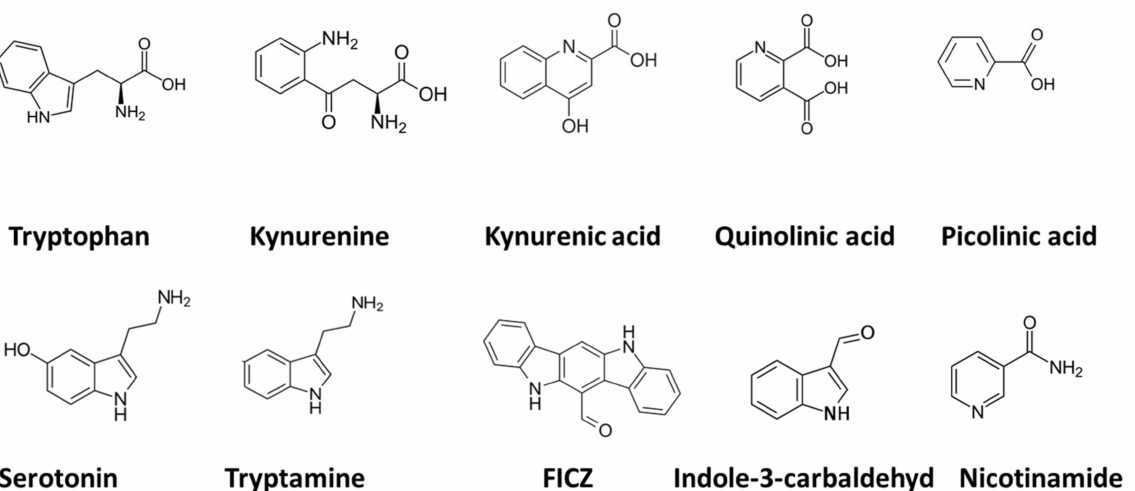
Figure 2. Chemical structures of tryptophan and derivatives mentioned in Figure 1. The term FICZ denotes the compound 6-formylindolo(3,2-b)